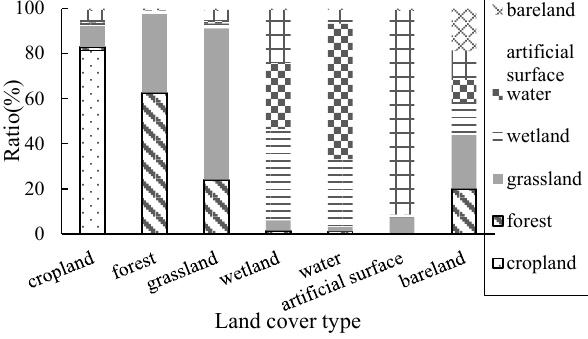
Figure 5. The confused degree of land cover types between our classification and GlobeLand30-2010 products (The abscissa in the figure represents the land cover type of globeland30-2010, and the ordinate represents the percentage of pixels in our classified product in a certain land cover type of globeland30-2010. When the abscissa is consistent with the land type of the ordinate, the land cover type is regarded as pure; otherwise, the ground type is regarded as confused).